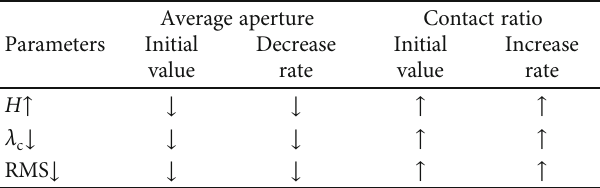
Figure 16: Creep deformation of the seven surface pairs (shown in Table 3). The time t is normalized by τ . (a) Mean aperture changing with time for the seven surface pairs; (b) contact ratio changing with time for the seven surface pairs. Table 5: Conclusions for the Maxwell model